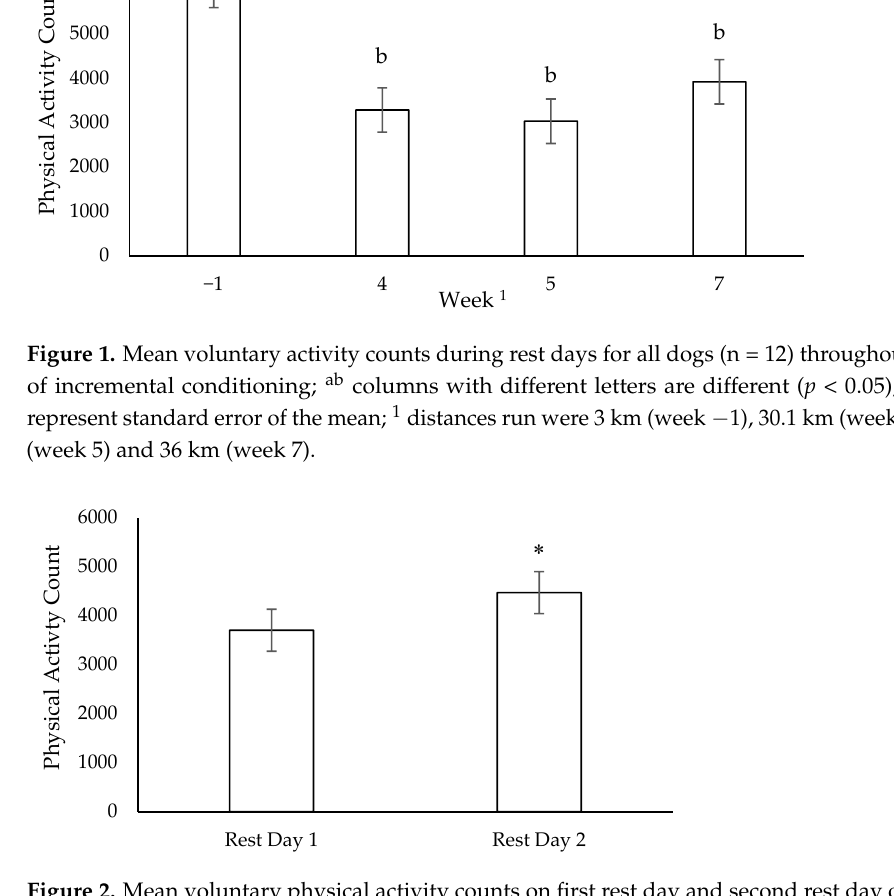
Figure 2. Mean voluntary physical activity counts on first rest day and second rest day of sled dogs (n = 12) undergoing 10 weeks of incremental conditioning; * significantly different ( p = 0.03); Error bars represent standard error of the mean.